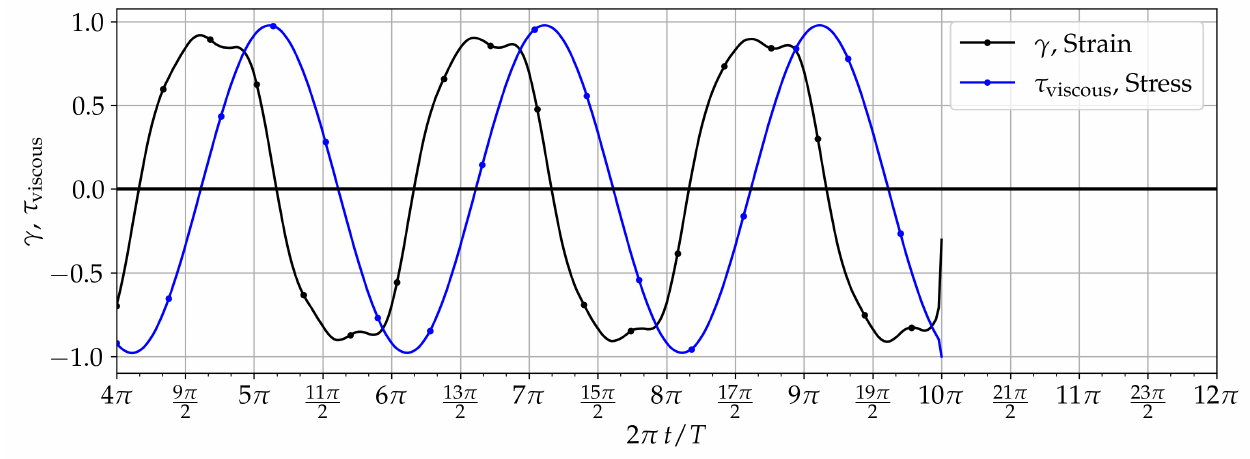
Figure 15. Shear stress τ and strain γ vs. time in the example viscous